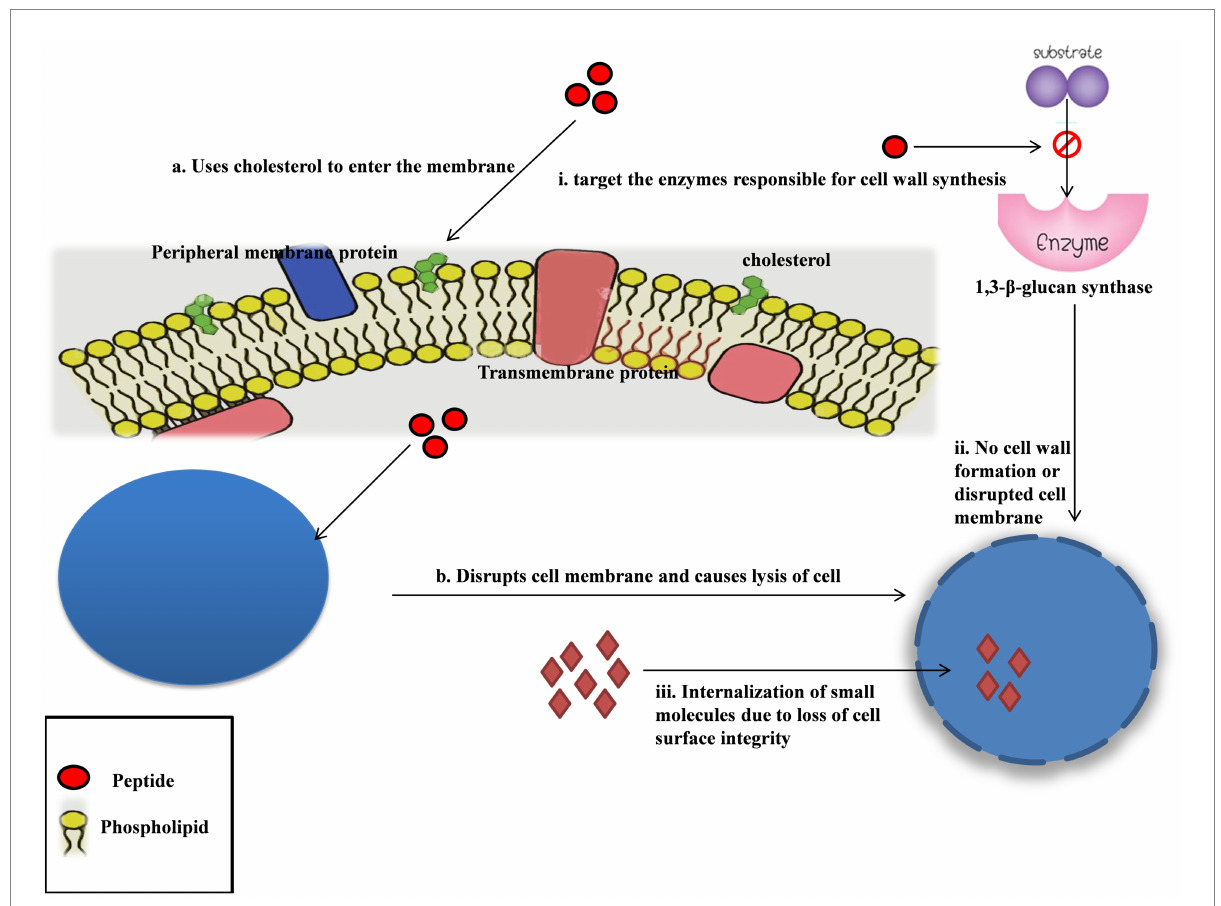
FIGURE 3 Mechanism of action of cyanobacteria as an antifungal agent. The peptides need cholesterol in the cell membrane to enter the cell, and from there on, they act by disrupting the cell membrane causing cell lysis. The peptides are hypothesized to target the enzyme responsible for cell wall synthesis. The increased internalization of molecules mainly implies a compromised cell membrane, confirming that these peptides majorly target the cell